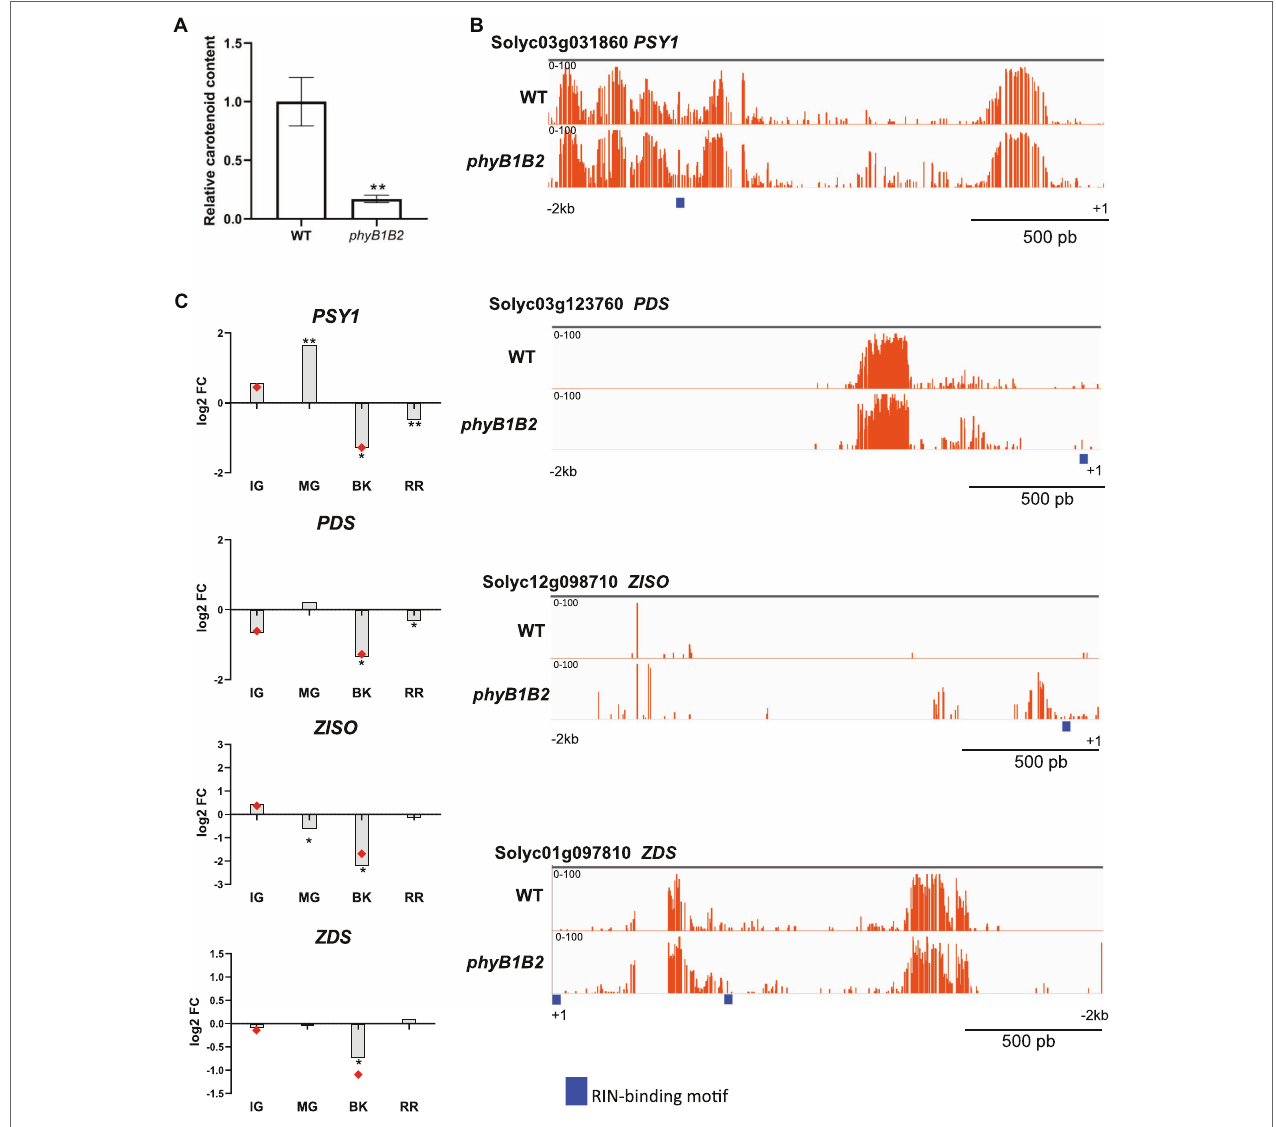
FIGURE 5 | PHYB1/B2-dependent regulation of fruit carotenogenesis relies on the promoter demethylation of key carotenoid biosynthetic genes. (A) Relative contents of total carotenoids in red ripe (RR) fruits from phyB1B2 and WT genotypes. Values represent the mean of at least three biological replicates. Asterisks indicate statistically significant differences by the two-tailed Student’s t- test between genotypes (** p < 0.01). (B) Differentially methylated promoter sites of the PHYTOENE SYNTHASE 1 ( PSY1 ), PHYTOENE DESATURASE ( PDS ), 15-CIS- ζ -CAROTENE ( ZISO ) and ZETA-CAROTENE DESATURASE ( ZDS ) loci between the phyB1B2 and WT genotypes. Orange bars indicate cytosine methylation levels in breaker (BK) fruits. Thick blue lines indicate RIN binding sites according to ChIP- seq data (Zhong et al., 2013). (C) Relative expression of carotenoid biosynthetic enzyme-encoding genes in immature green (IG), mature green (MG), BK and RR fruits from phyB1B2 determined by RT-qPCR. Red dots indicate data from RNA-seq in the same stage. The expression levels represent the mean of at least three biological replicates and are relative to WT. Asterisks indicate statistically significant differences by the two-tailed Student’s t- test compared to WT (* p < 0.05 and ** p <